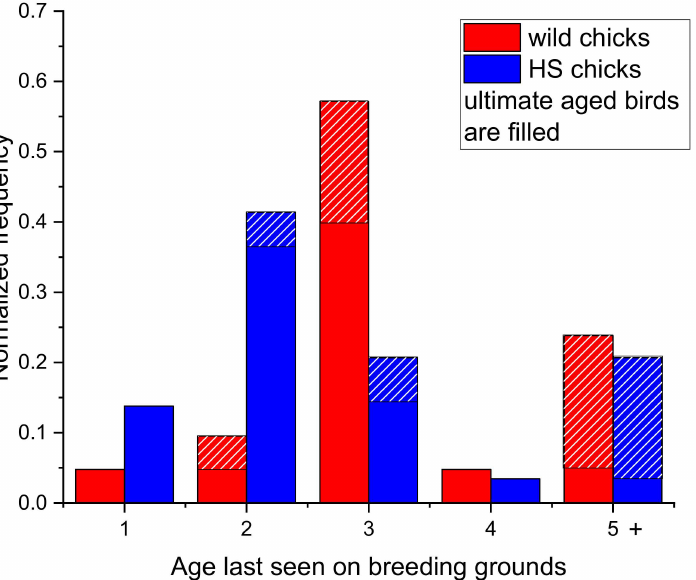
Figure 7. Maximum age at the last observation on breeding grounds of HS and wild SbS chicks. The hatched sections indicate birds that could not have exceeded the particular age at the time of